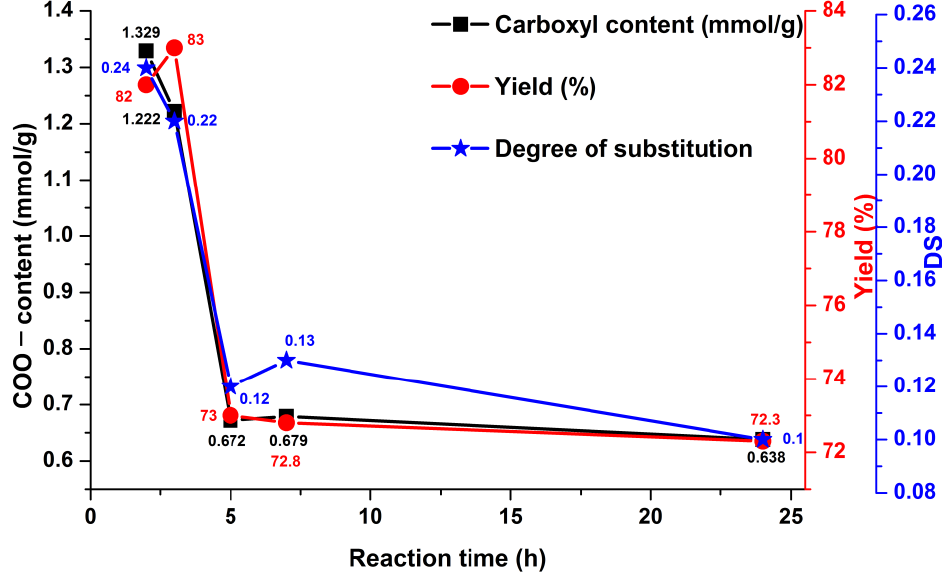
Figure 4. The effect of reaction time on the carboxyl content, degree of substitution, and yield of the oxidized pullulan.